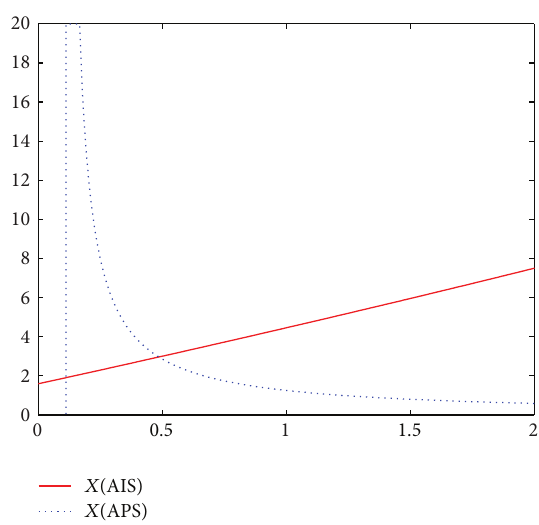
Figure 4: Equilibrium net profits.